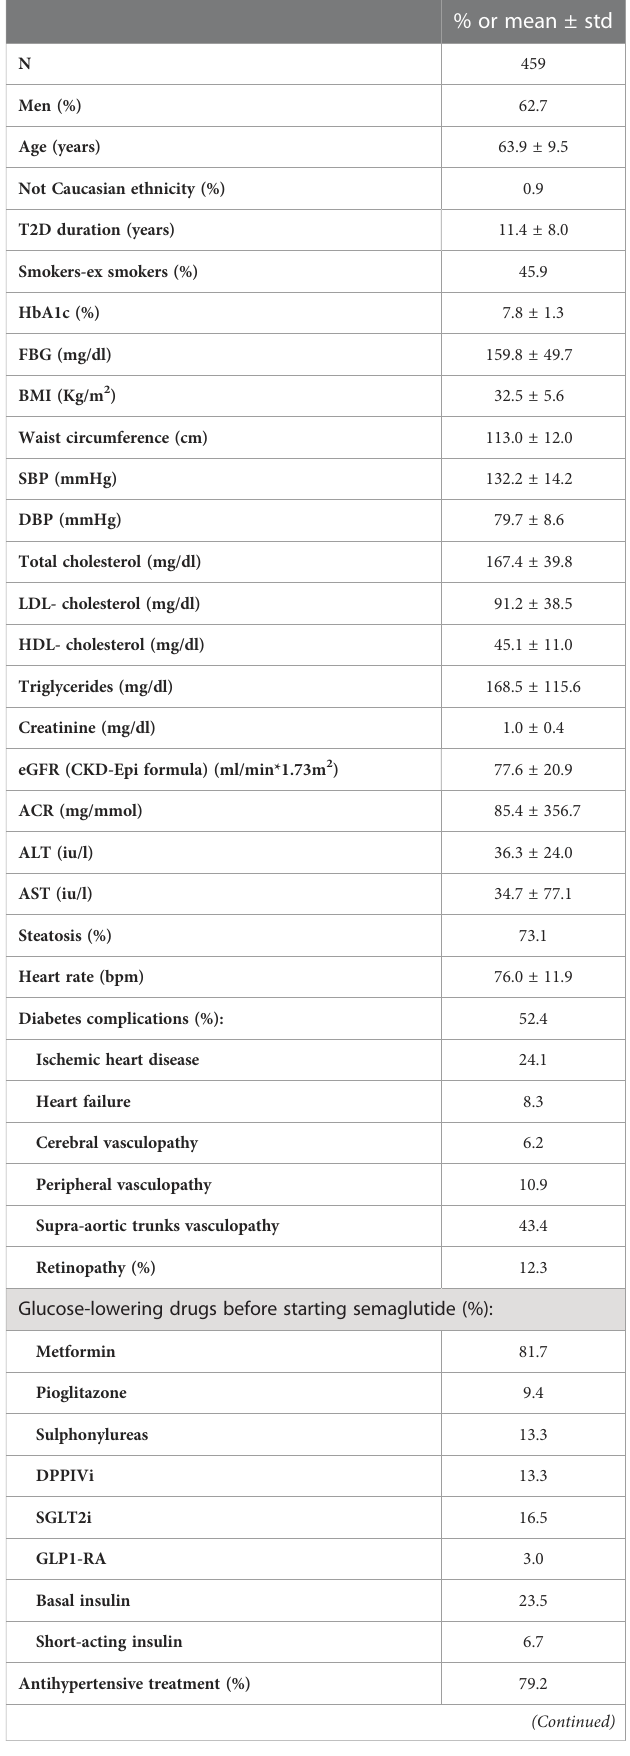
TABLE 1 Baseline patients ’